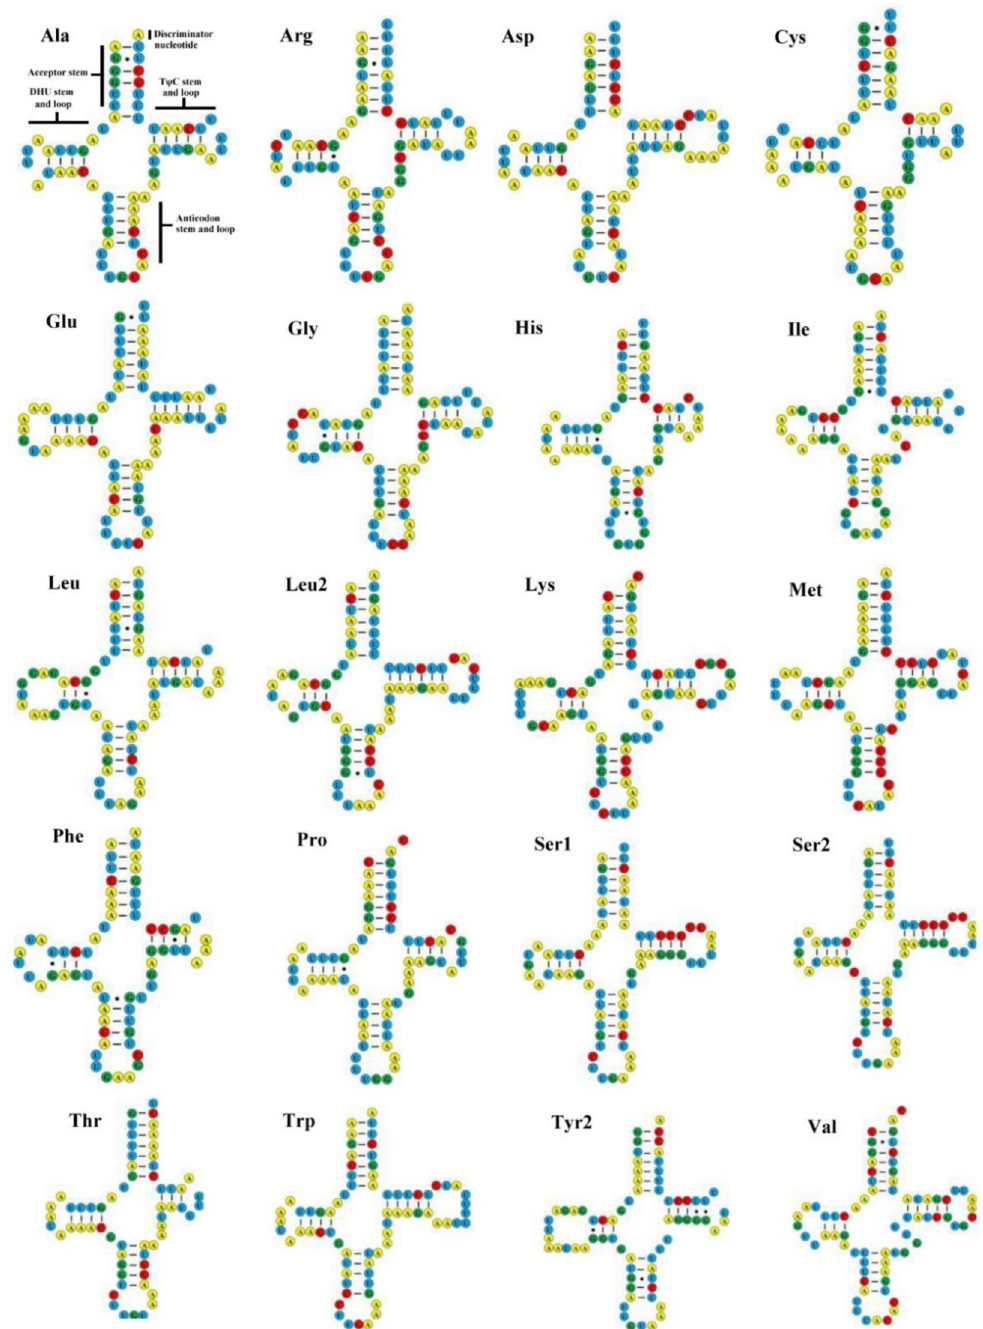
Fig 2. Inferred secondary structures of 20 transfer RNAs (tRNAs) identified in Amorphoscelis chinensis . Bars indicate Watson-Crick base pairings, and dots between G and U pairs mark canonical base pairings in